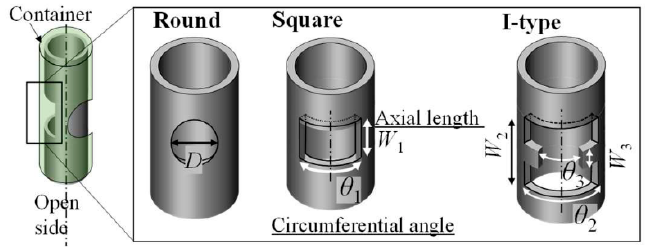
Figure 9. Variations of cutouts shape and position.